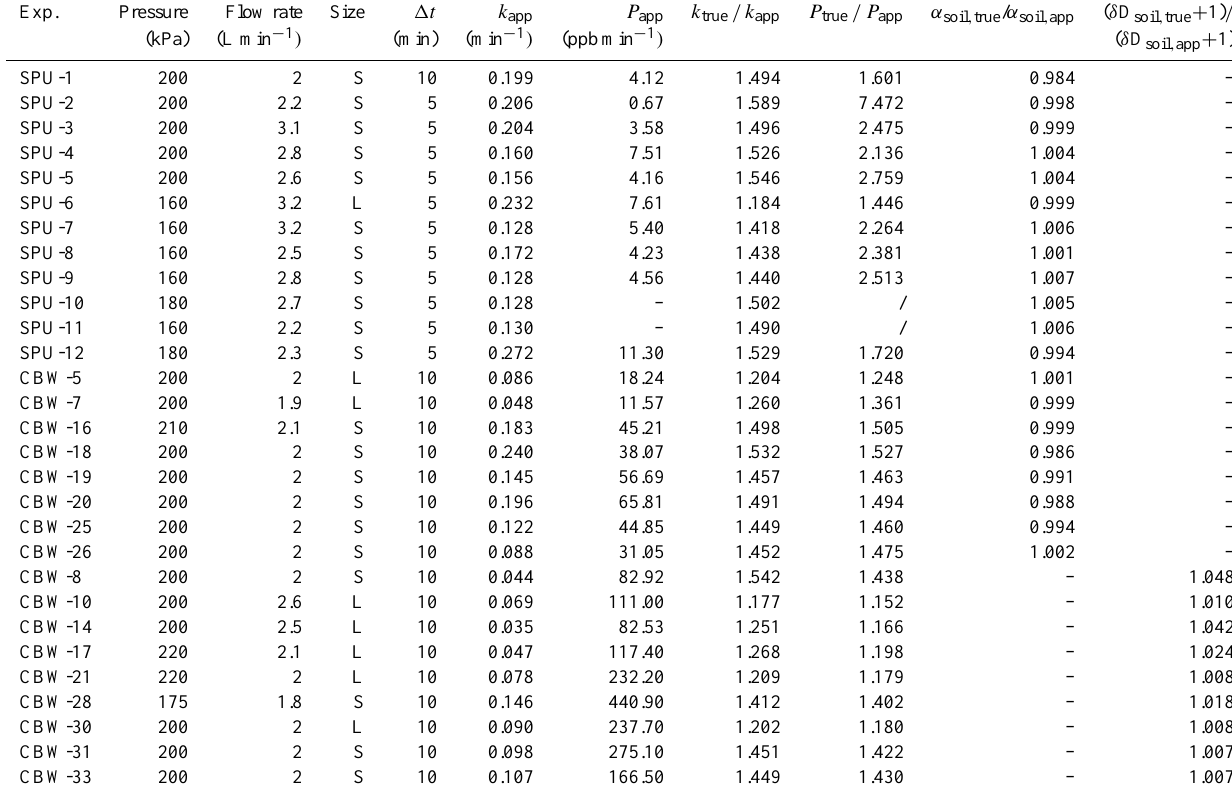
Table 3. Sampling information and the correction coefficients ( k true /k app , P true /P app , α soil , true /α soil , app and ( δ D soil , true + 1) / ( δ D soil , app + 1) used for each experiment. Size S refers to small chamber and sizeL refers to large chamber.